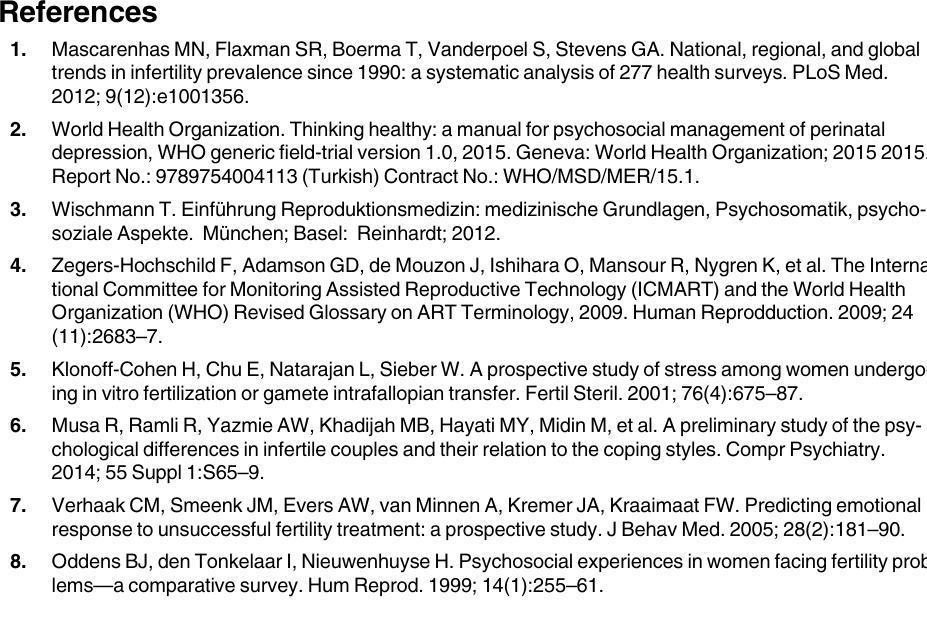
S5 Table. CMA Data for pregnancy rates. Data for pregnancy rates used in CMA software to calculate